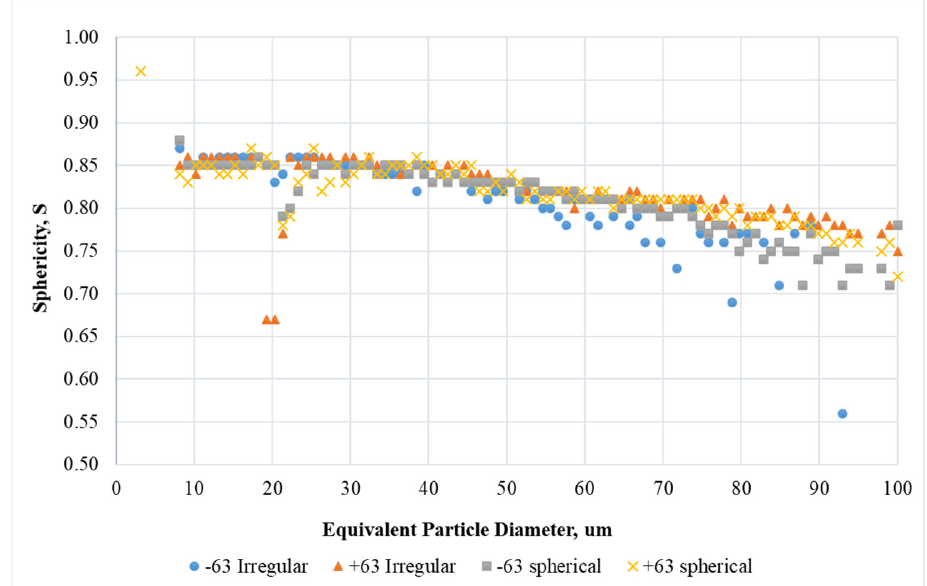
Figure 8. ( a ) The frequency and ( b ) cumulative distribution curves for AISI 304 SS irregular and spheroidised powder.